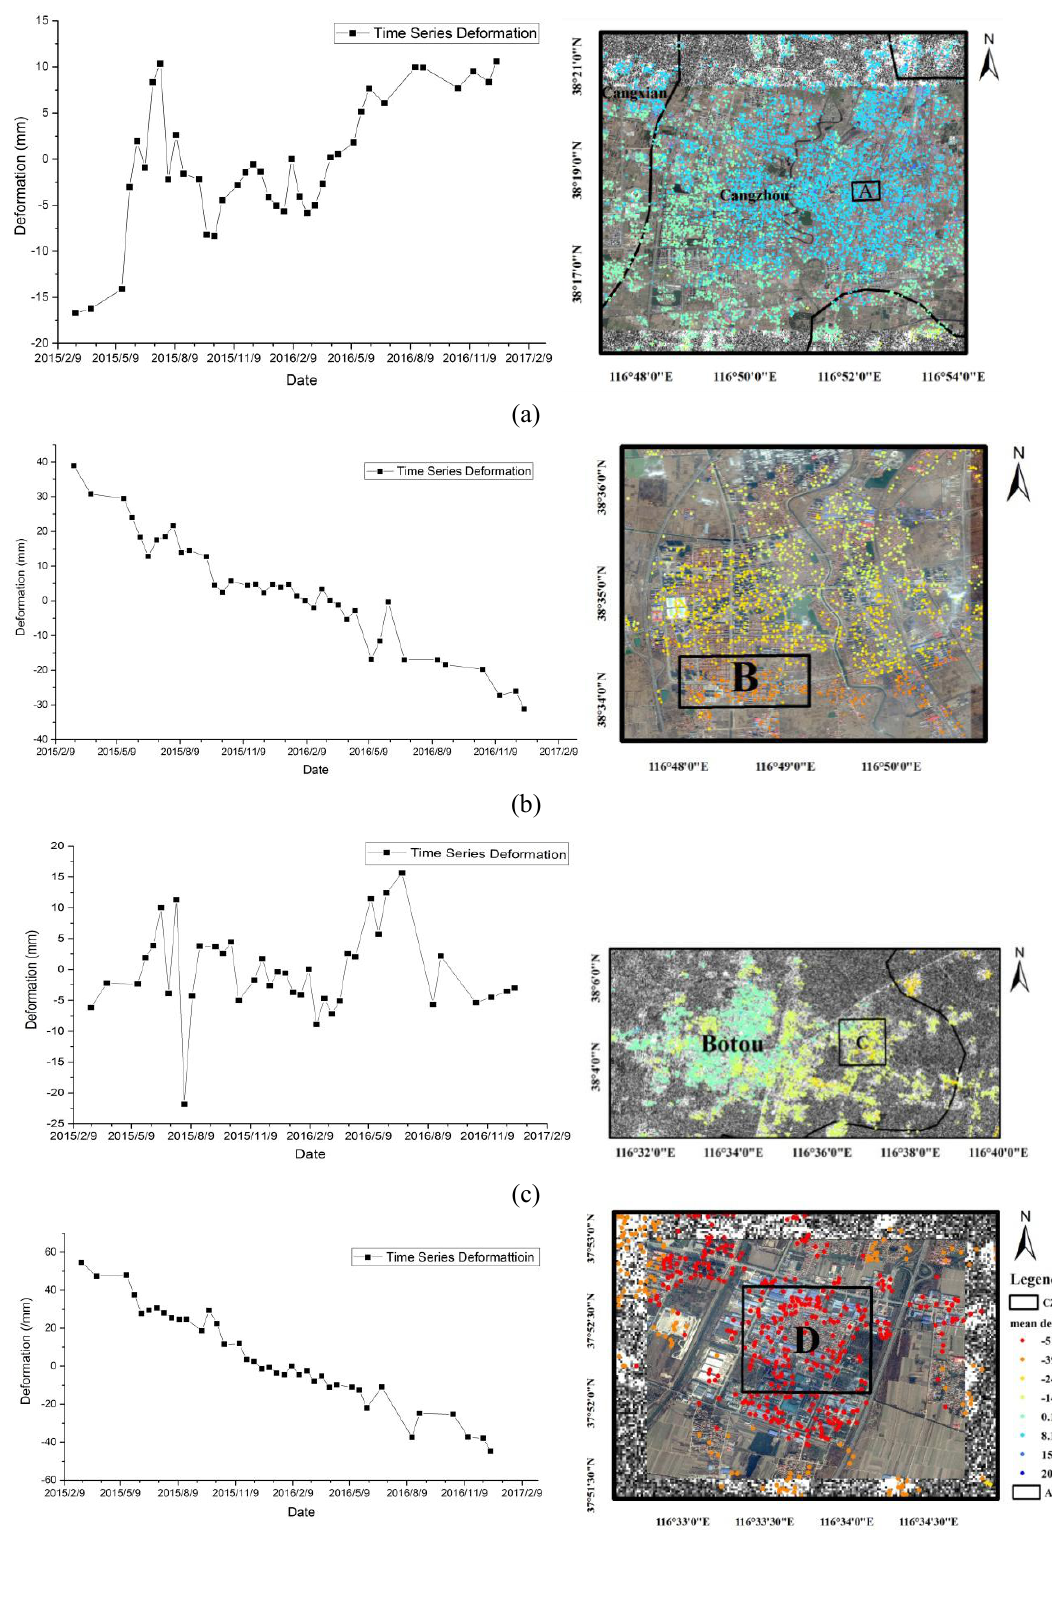
Figure 3. Cangzhou area of the settlement deformation rate map, the red wireframe represented the focus area .The subsidence of Qing-east of Cangxian-Nanpi-Dongguang along the north and south of Cangzhou was serious obviously; especially in some areas of Qing and Dongguang, the cumulative settlement was more than 30mm / a, and the most serious areas of the subsidence reached 50mm/a; compared to the east along the Xian-west of Cangxian-urban areas began rebounded referring to the reference